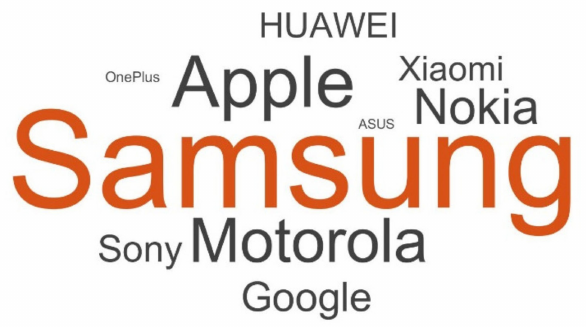
Figure 11. Word-cloud plot analysis for brand and its total number of reviews.